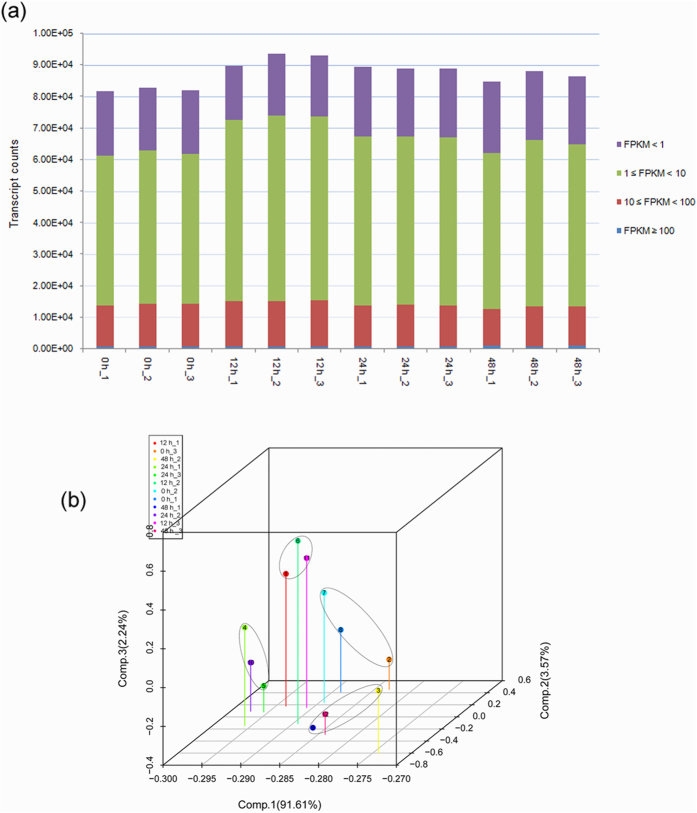
Global analysis of transcriptome datasets of biological replicates.(a) Bar plot describing the number of expressed transcripts after filtering. (b) Principal component analysis (PCA) of transcriptome data; each dot represents a sample with the principal component value.